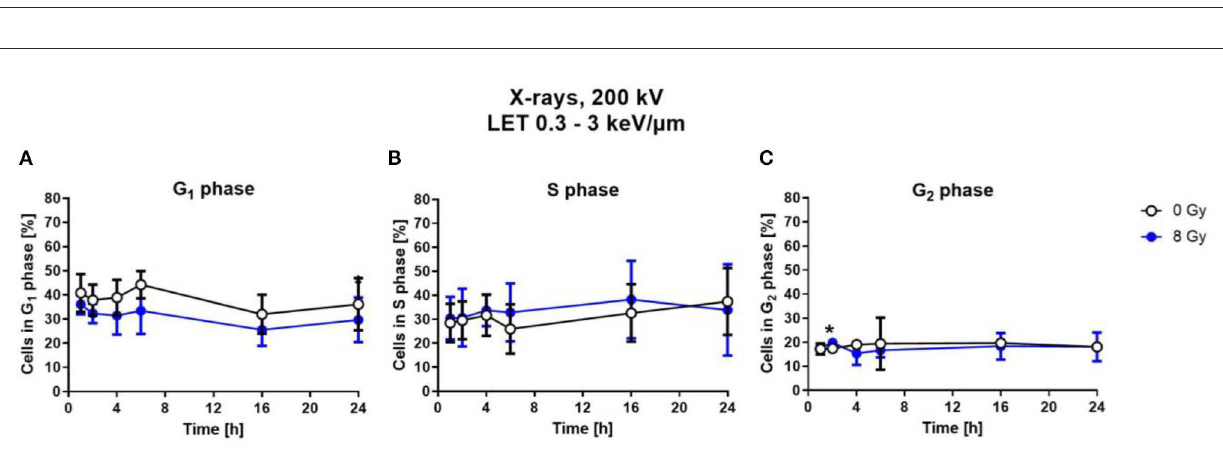
FIGURE5 Exposure to X-rays did not induce cell cycle arrests. Astrocytes were exposed to 8Gy X-rays or mock-irradiated (0Gy) and trypsinized and fixed at different time points up to 24h after irradiation. The percentage of cells in the different cell cycle phases—G 1 - (A) , S- (B) , G 2 -phase (C) — was determined by flow cytometry of DAPI stained cells. The distribution of cells in S- and G 2 -phase is comparable for both conditions. The samples were compared by unpaired t -test with a sample size of n = 6. Data are shown as mean ± SD. Significant differences in comparison to the 0Gy control at the same time point are indicated by asterisks (* p <